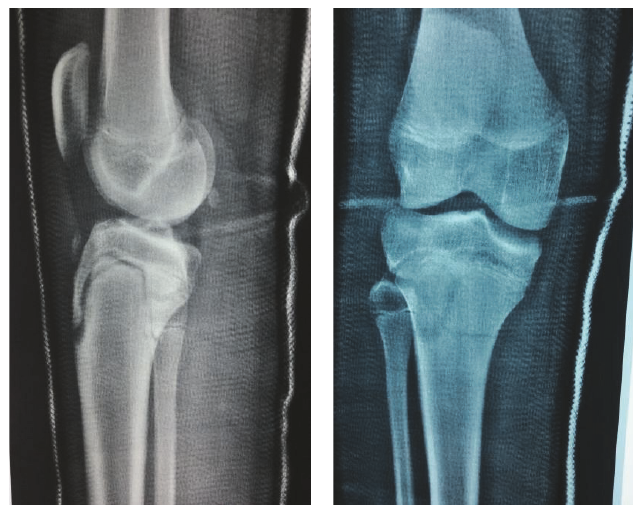
Figure 3: Plain radiographs one week after